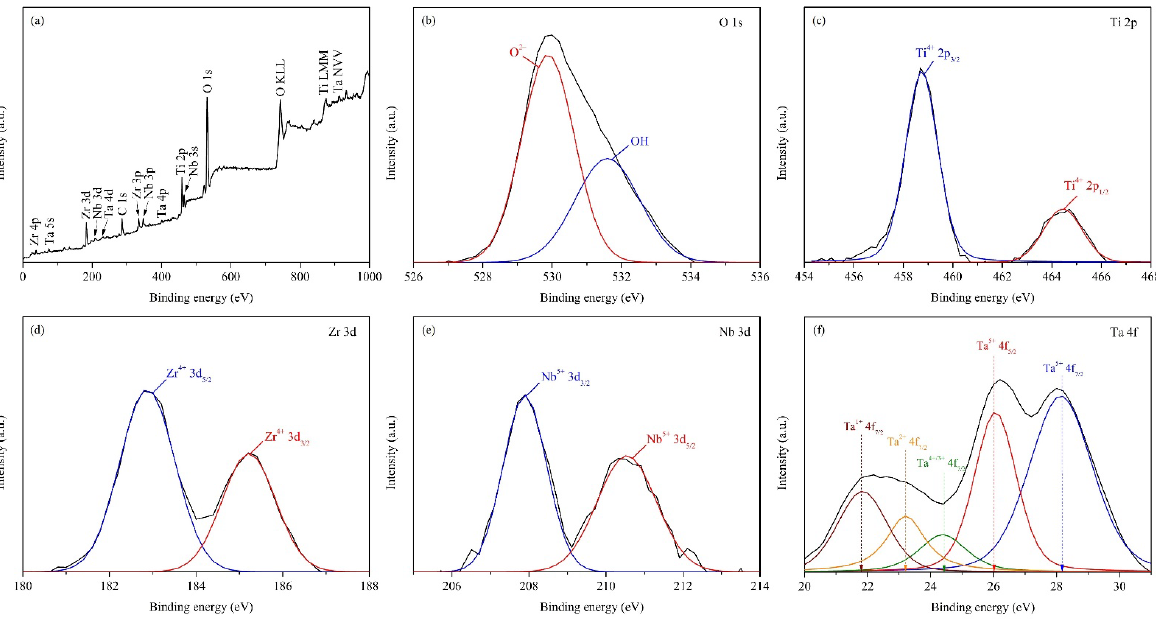
Figure 12. Chemical characterization of the Ti 65 –Zr 29 –Nb 3 –Ta 3 surface after potentiodynamic polar- ization test: ( a ) full spectrum and ( b – f ) narrow scans. ization test: ( a ) full spectrum and ( b – f ) narrow